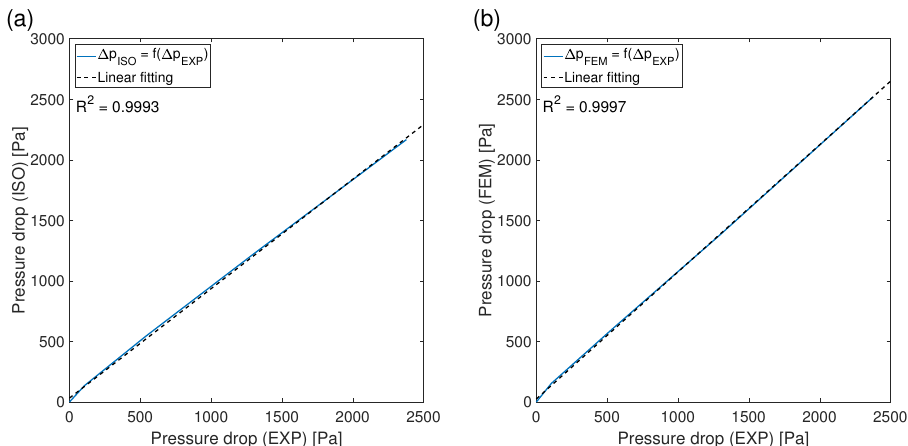
Figure 8. Coefficient of determination R 2 between ( a ) analytical (ISO) and experimental results and ( b ) numerical and experimental results for the configuration of splitter silencers with rectangular profiles.